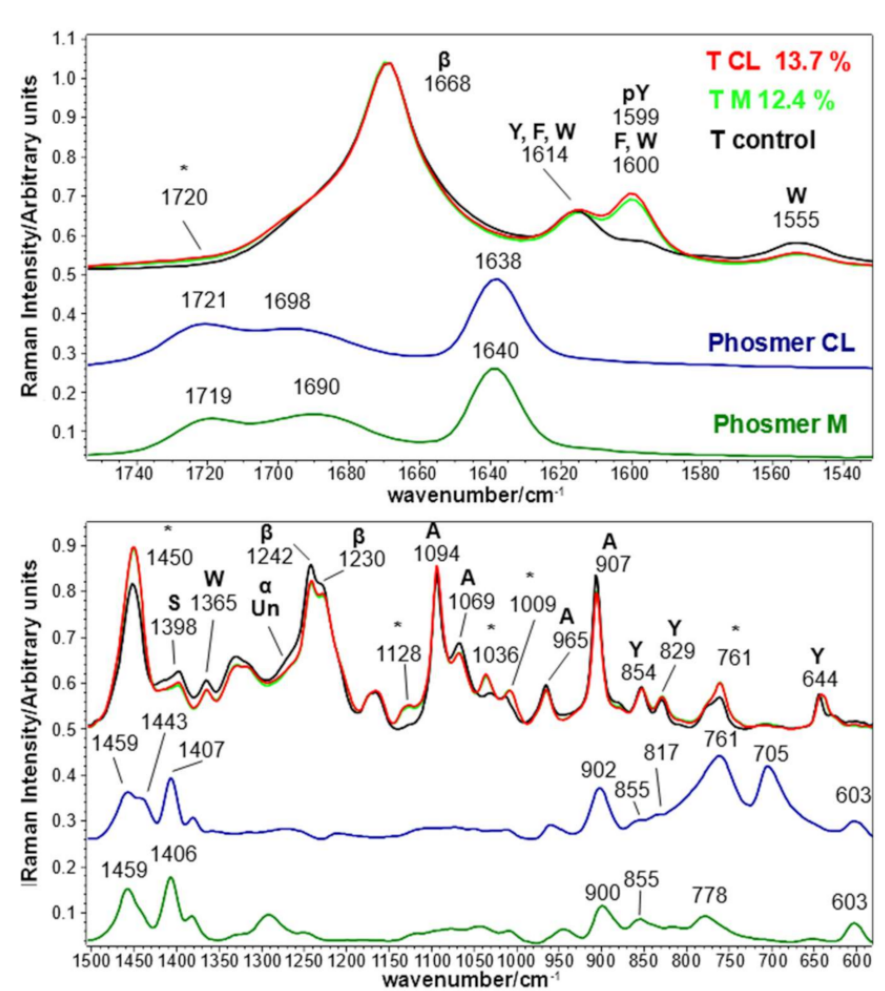
Figure 8. Raman spectra of Tussah silk fibroin fabrics before (control) and after grafting with phosmer CL (weight gain 13.7%) and M (weight gain 12.4%). The spectra are normalized to the Amide I band. The spectra of phosmers CL and M are reported for comparison; the main bands that in the grafted samples strengthened due to their contribution are indicated with * (see Supplementary Material for assignments). The main bands assignable to β -sheet ( β ), α -helix ( α ) or unordered (Un) conformation as well as to tyrosine (Y), phenylalanine (F), phosphorylated tyrosine (pY), serine (S), tryptophan (W) and poly-alanine-rich segment (A) are